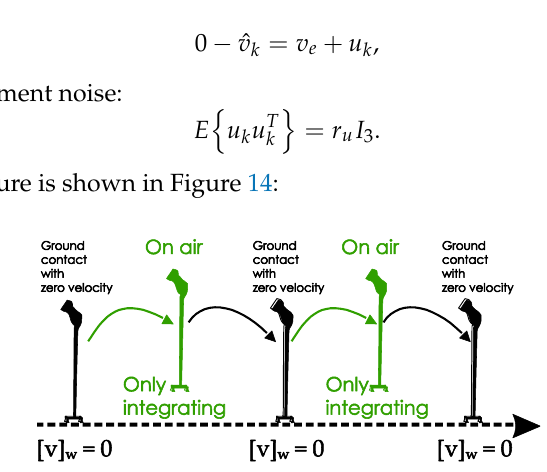
Figure 14. Velocity updating procedures for a quadripod cane.